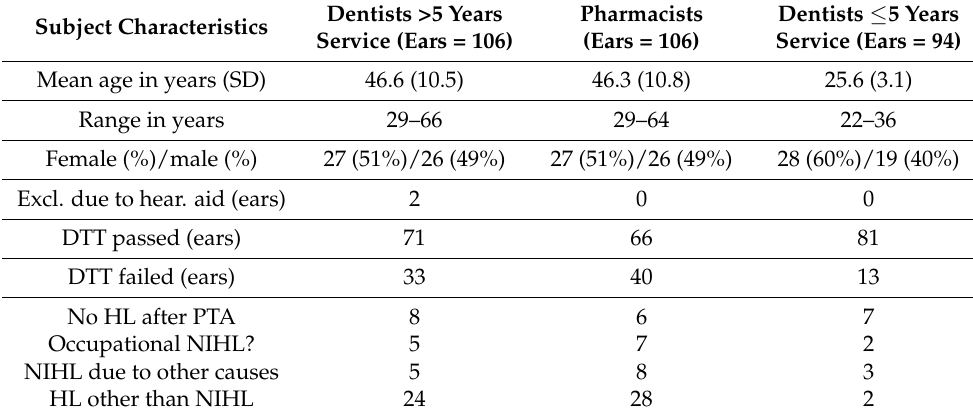
Table 1. Main demographics of the two groups of dentists and the